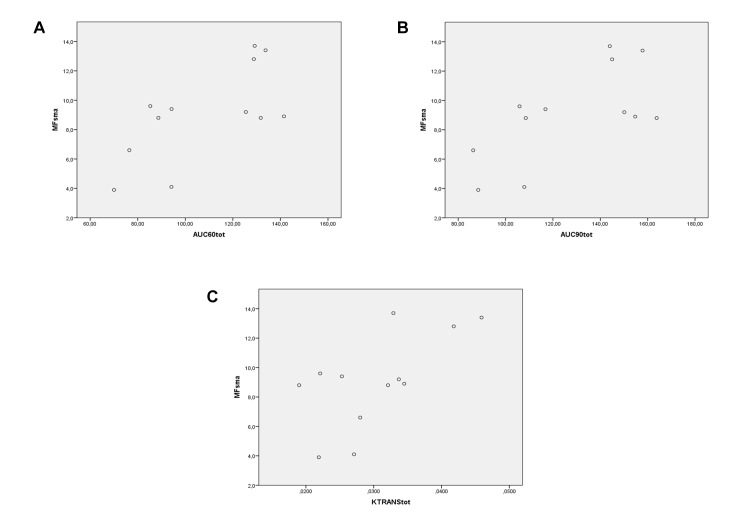
Spearman rank correlation analysis.Correlation between MRI perfusion parameters (on the horizontal axis)—AUC60 (A), AUC90 (B), and Ktrans (C)—in the whole small bowel—of PNH patients and MF of SMA (on the vertical axis).